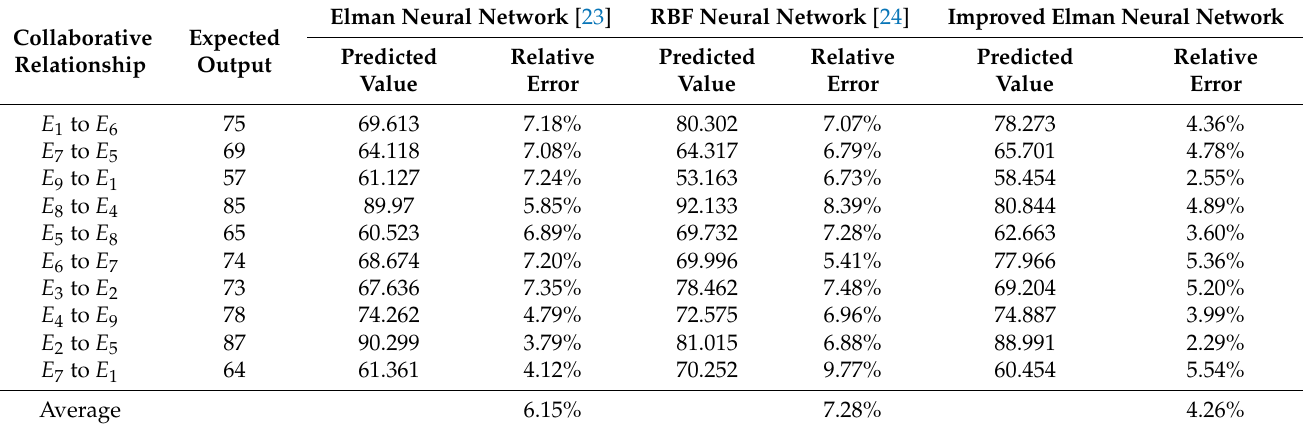
Table 6. The output results and error comparison of the proposed model and other models.